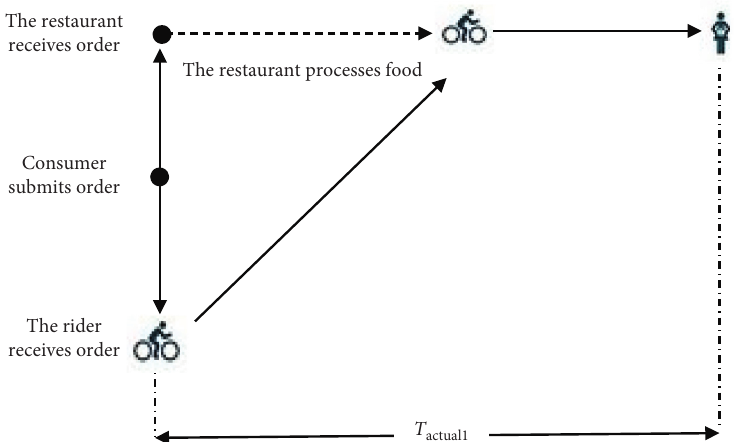
Figure 1: Schematic diagram of rider delivery model.